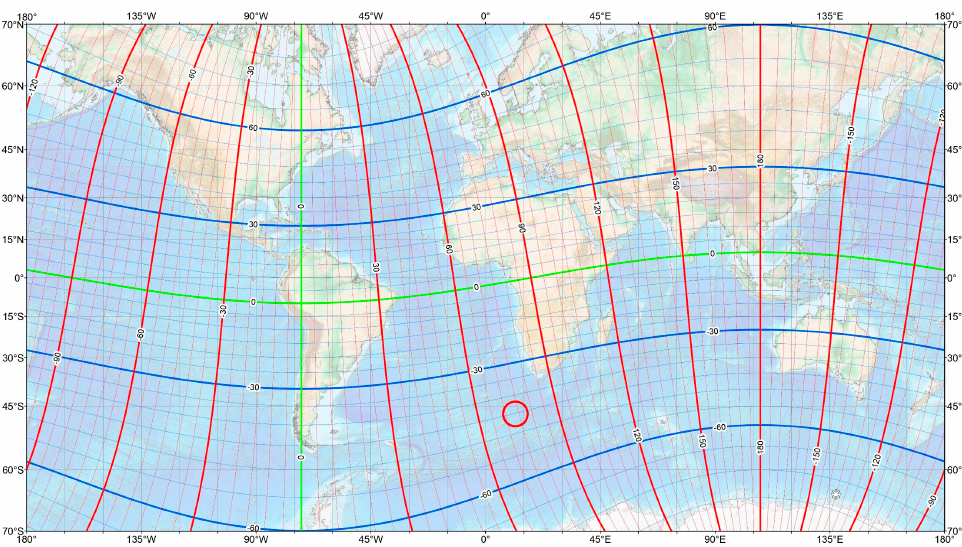
Figure 2. Geomagnetic coordinates map [9] with the conjugate point of Spain in a red circle.